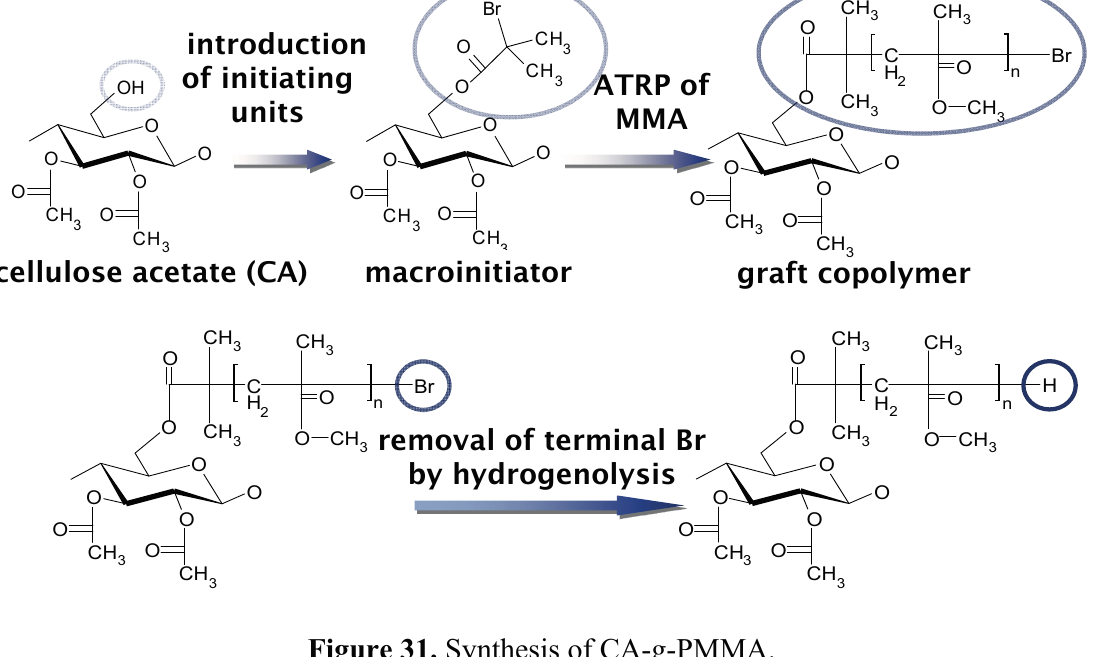
Figure 31. Synthesis of